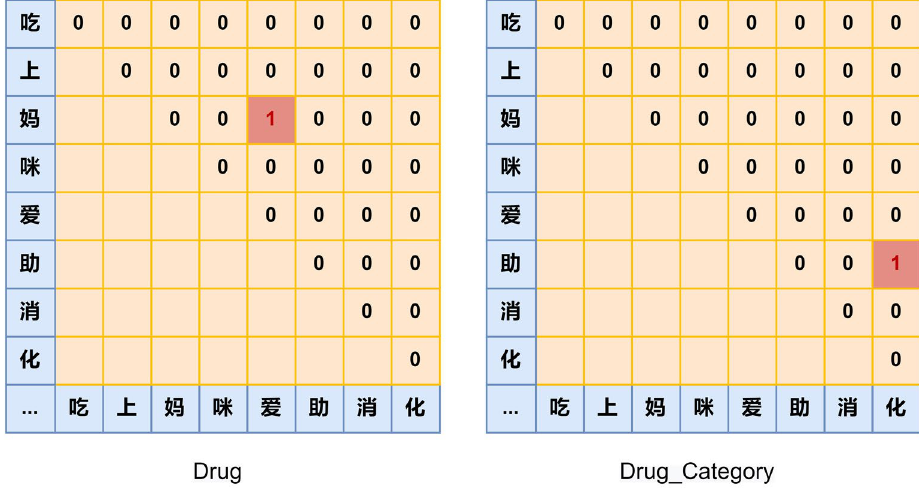
Figure 2. A demo of global